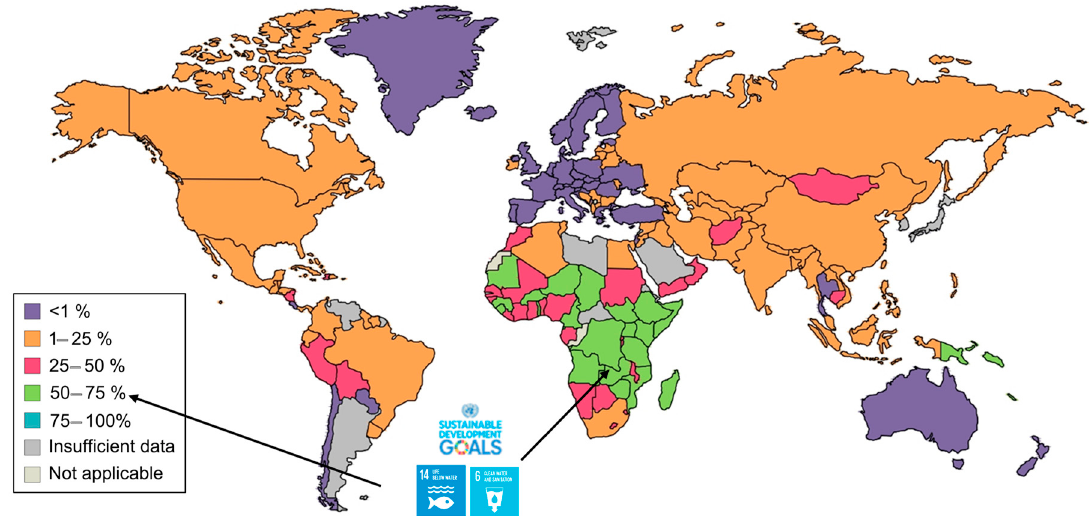
Figure 1. Percentage of the rural population using surface water or groundwater for drinking needs without any treatment. Focus on Sub-Saharan region. (Adapted from [15]).